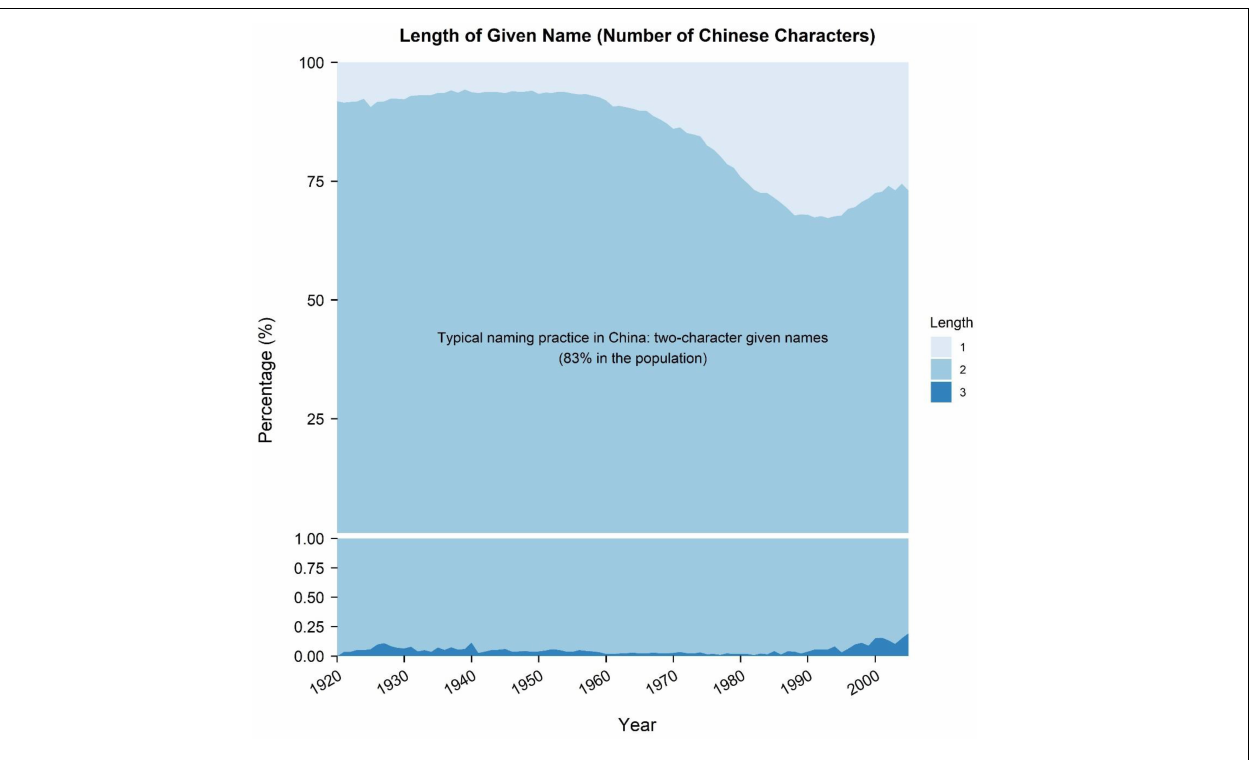
FIGURE 1 | Trends of the percentages of one-, two-, and three-character given